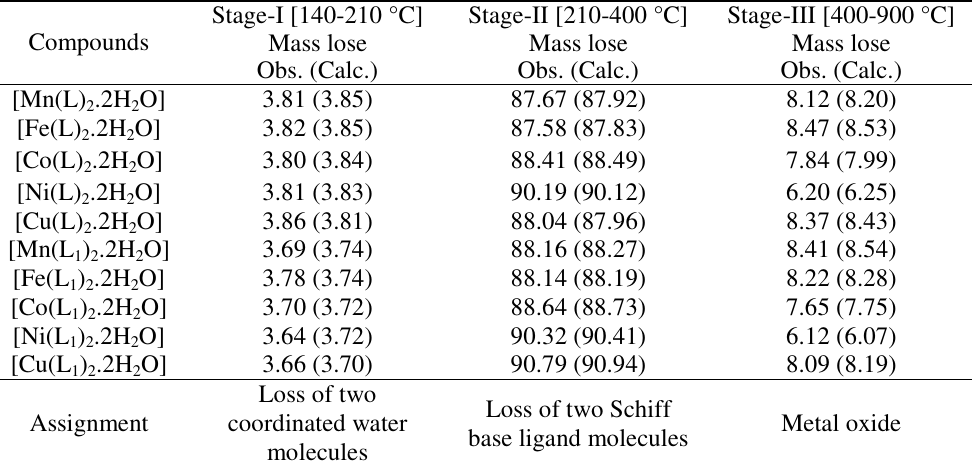
Table 5. Thermo analytical results of metal complexes of Schiff base ligand L and ligand L